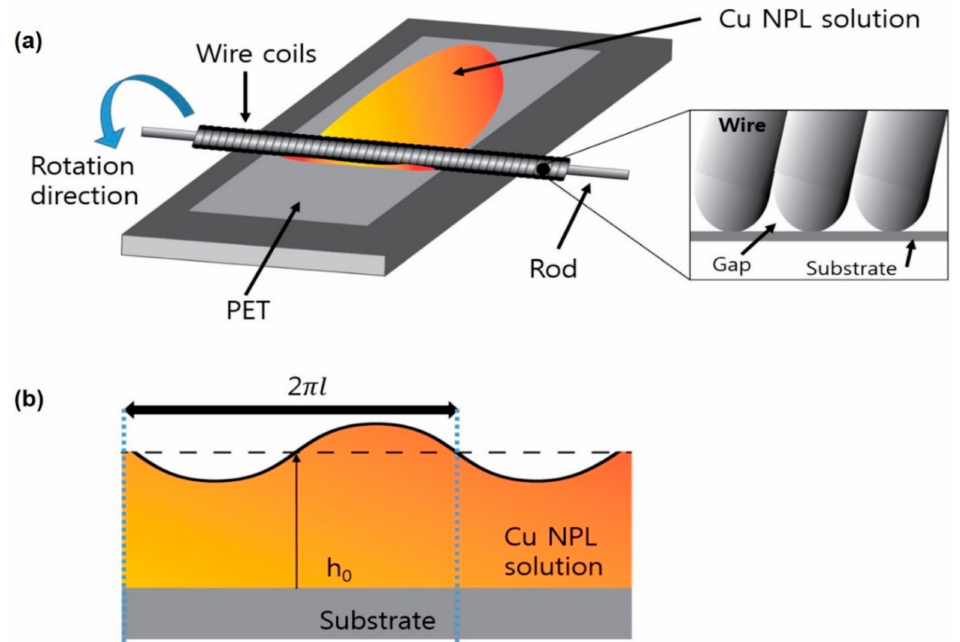
Figure 1. Schematic diagram of Meyer-rod coating process for Cu-plate solution. ( a ) Cu nanoplate (NPL) solution is coated with rotating rod at the ratio of 1:1 (rotation speed to coating speed) on polyethylene terephthalate (PET). The gap generated between wires determines coating thickness during leveling process. ( b ) Illustration of Cu NPL leveling process based mainly on surface tension and viscosity (wavelength of a sinusoidal disturbance and initial coating thickness are defined as 2 π l and h 0 ,